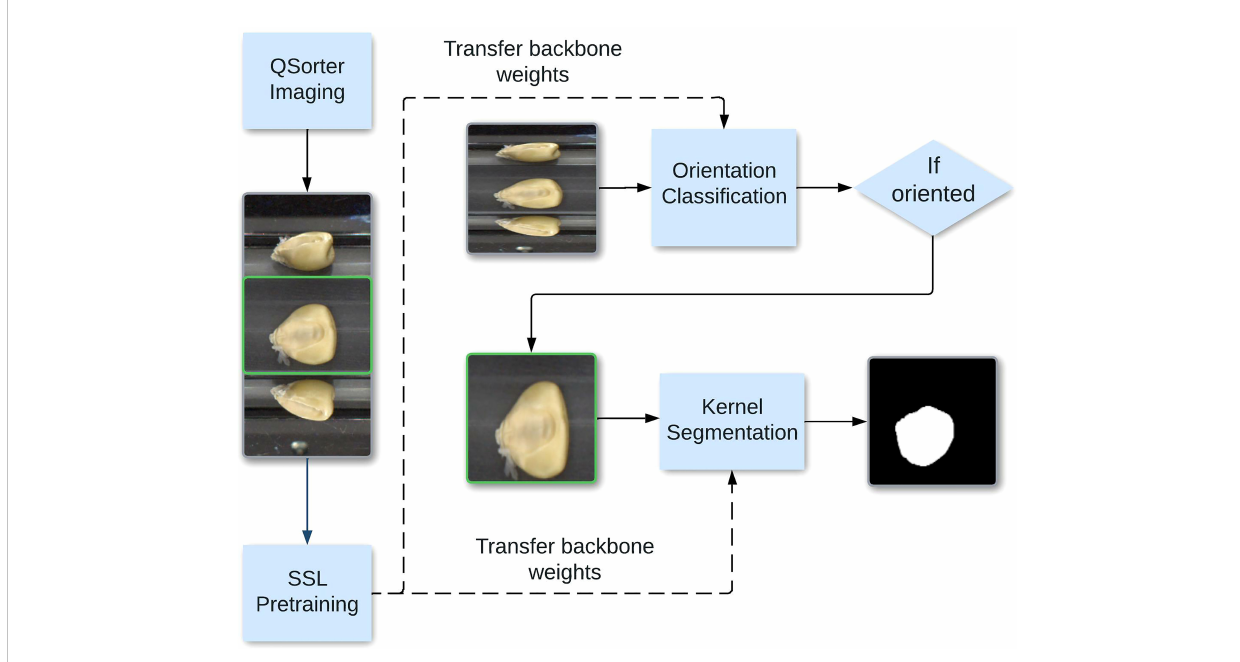
FIGURE 1 End-to-end pipeline for corn kernel classi fi cation and segmentation. The curved arrow shows the middle pane being processed for the segmentation task. We show that the classi fi cation and segmentation models perform bets with self-supervised